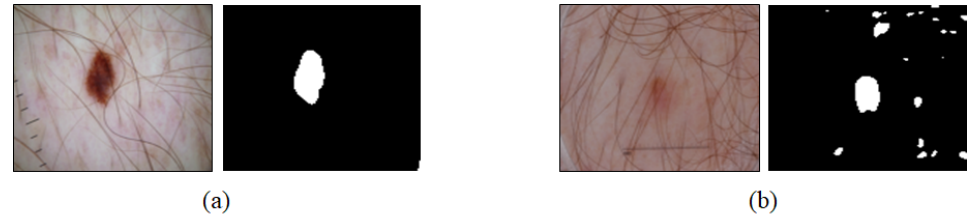
Figure 8. Examples of noise-robust and noise-vulnerable cases. ( a ) Lesion is clearly contrasted from the skin and ( b ) lesion is unlikely to be contrasted from the skin.